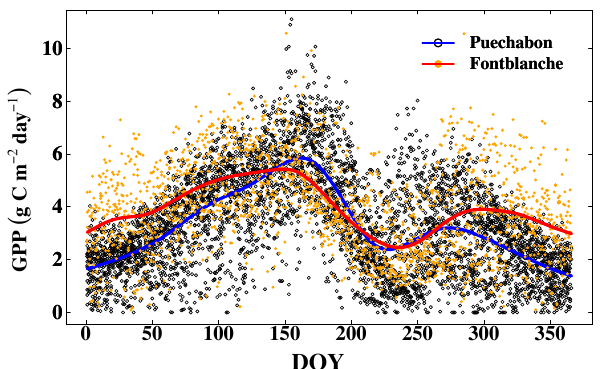
Figure 3. Daily gross primary productivity (GPP) at Puechabon (2001–2013, black dots, blue line) and Fontblanche (2008–2012, orange dots, red line). DOY: day of year. Thick lines correspond to smoothers fitted to the mean to highlight seasonal trends at the two